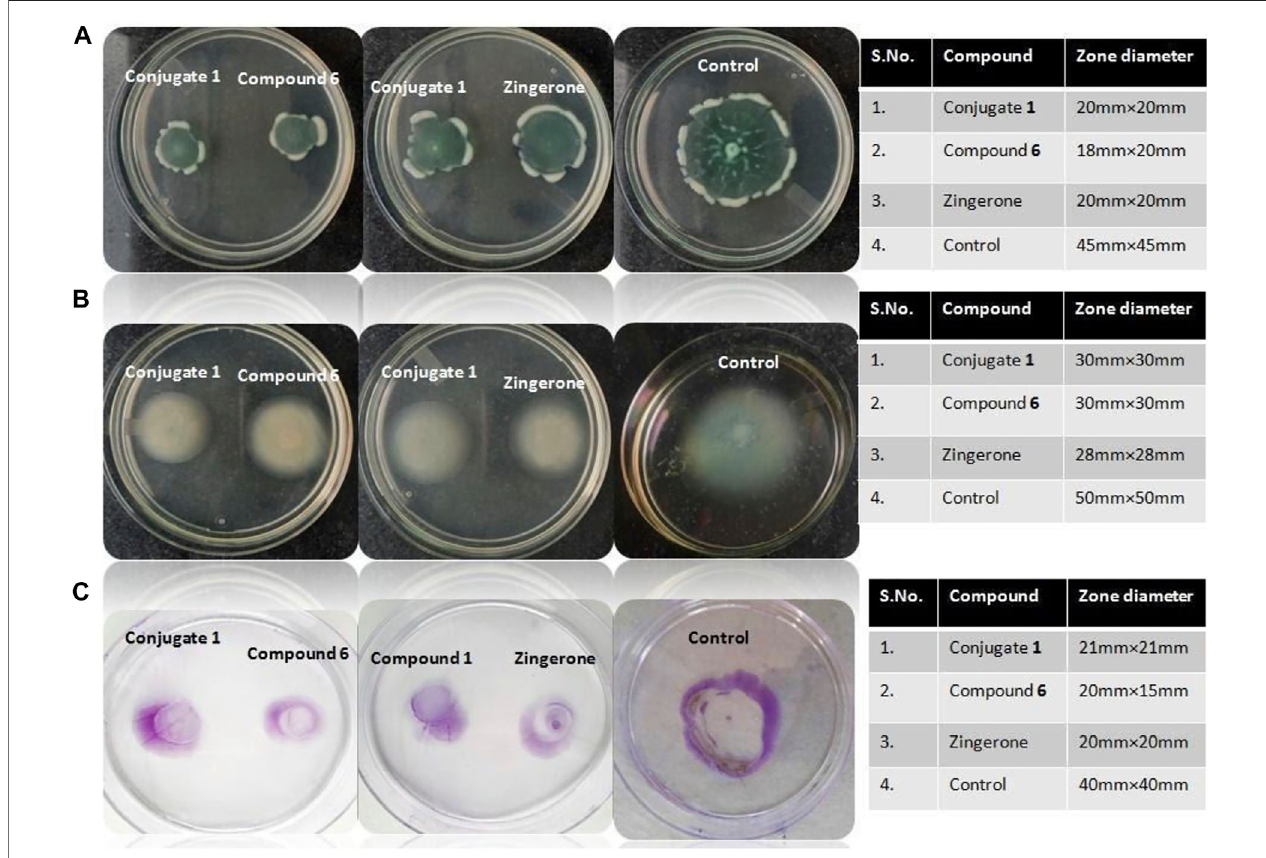
FIGURE 5 | Antimotility effects of catechol – zingerone conjugate ( 1 ), compound ( 6 ), and zingerone alone. Swarming (A) , swimming (B) , and twitching (C) motility patterns of P. aeruginosa in absence (control) and presence (tests) of sub-MIC of catechol – zing conjugate 1 , compound 6 , and zingerone alone.